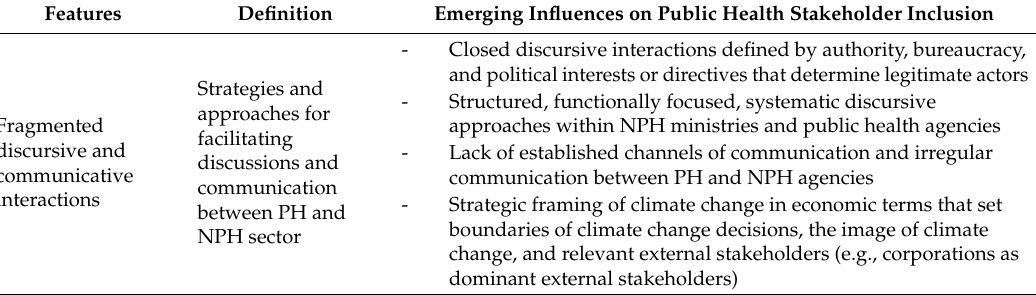
Table 3. Main themes emerging as influences of public health stakeholder engagement, as guided by CDA, analysis of institutions and narratives, and institutional engagement elements from the literature